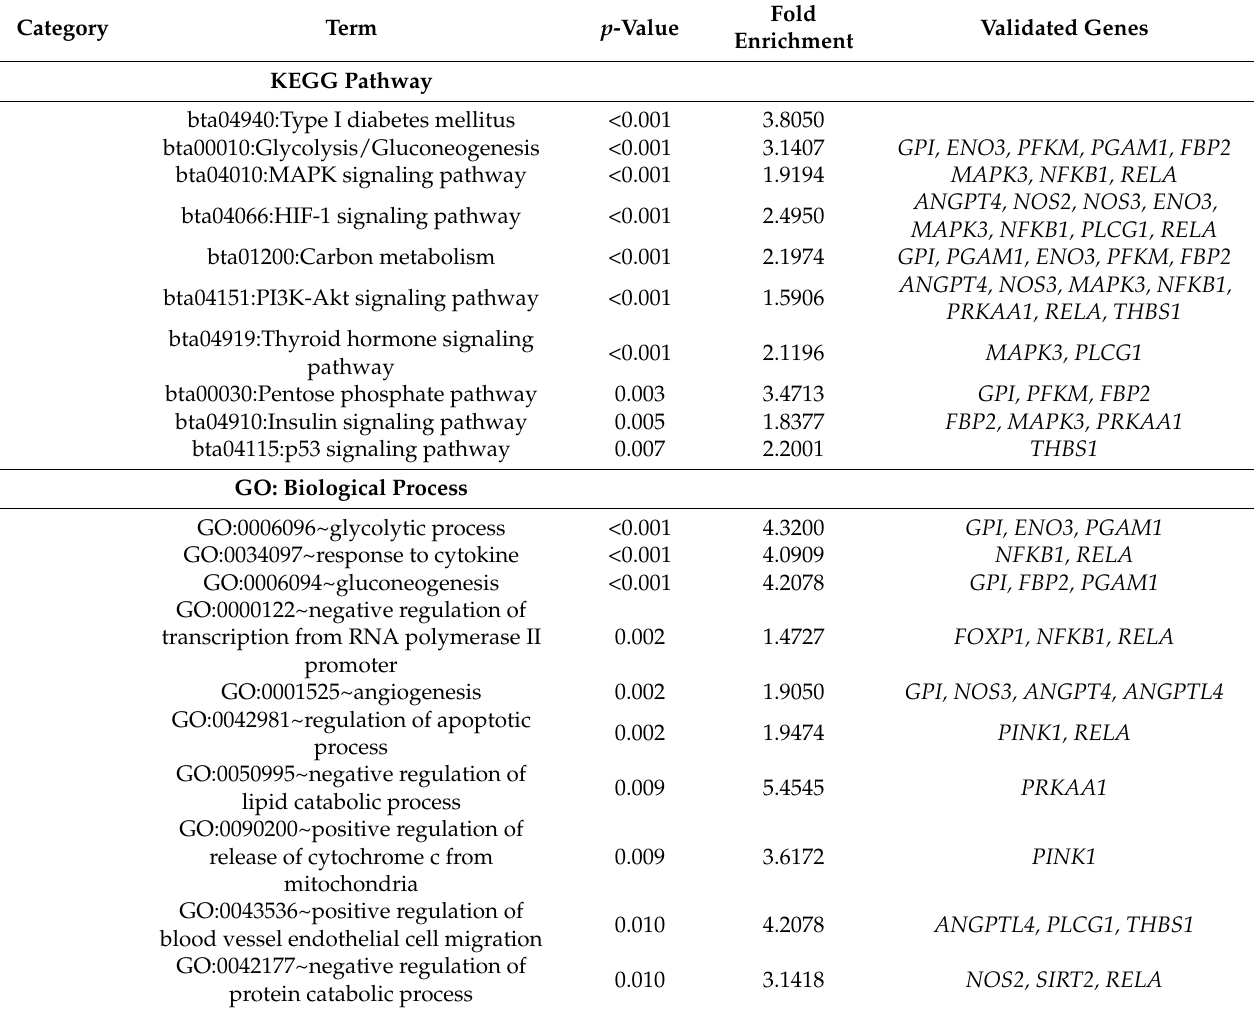
Table 4. Fetal growth and energy associated metabolisms and pathways extracted from downregulated genes *.